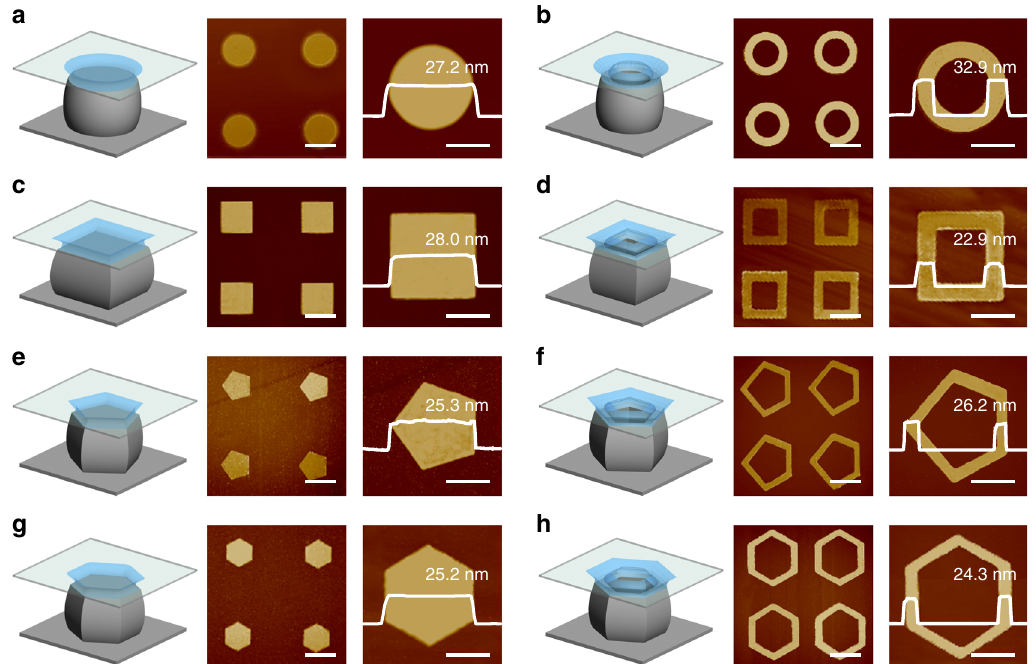
Fig. 5 Morphology tailoring of single-crystalline organic ultrathin nanostructured arrays with tunable shapes. a – h Controlling assembly induced by con fi ned crystallization of single-crystalline organic ultrathin nanostructured arrays with shapes of a circle, b circular ring, c square, d four-sided ring, e pentagon, f fi ve-sided ring, g hexagon, and h six-sided ring using corresponding micropillars. Scale bars: a – h 20 μ m (middle), 10 μ m